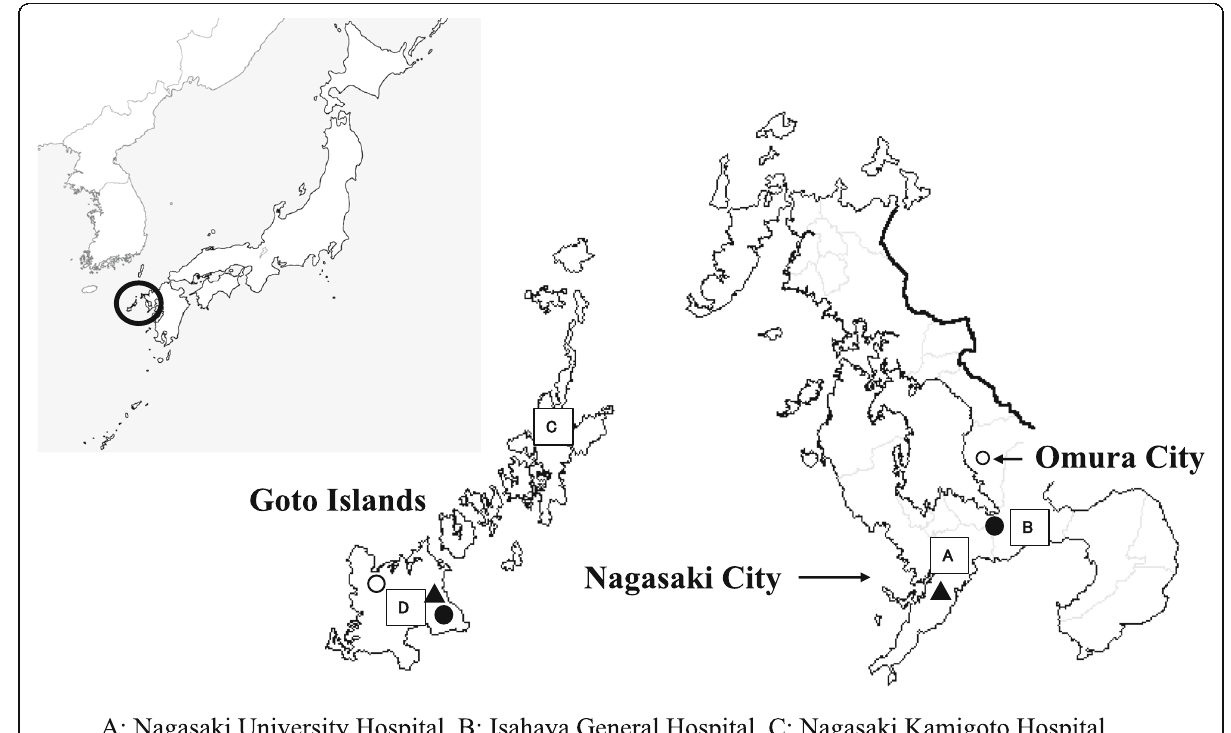
Fig. 1 Map of Japan (left) and Nagasaki prefecture